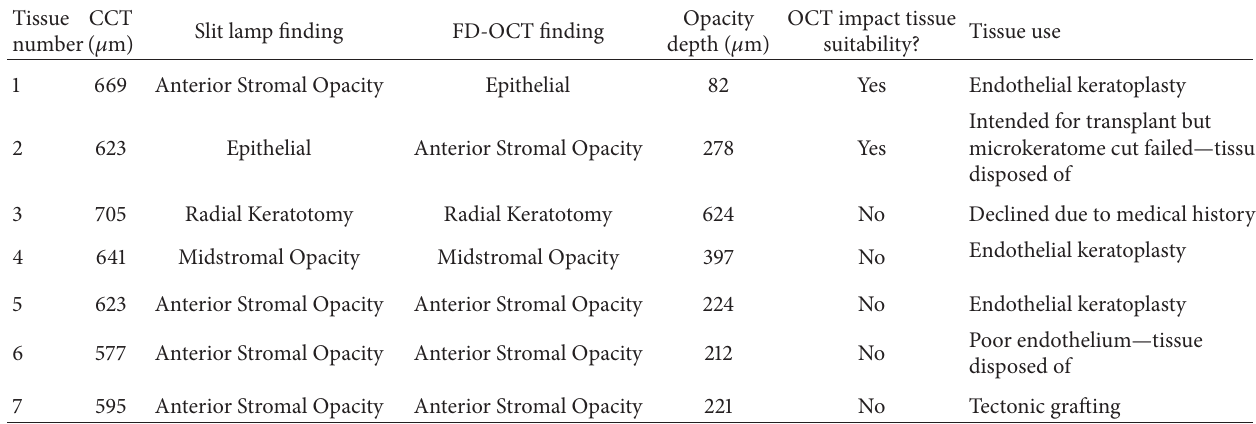
Table 1: Comparison of slit lamp and OCT findings in evaluating donor tissue for transplant suitability and depth of opacity as measured with